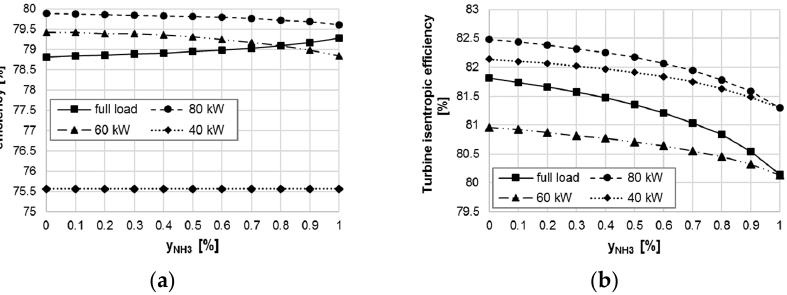
Figure 9. Effects of NH 3 feeding, at different levels of power output, on isentropic efficiency of: ( a ) compressor; ( b ) turbine.